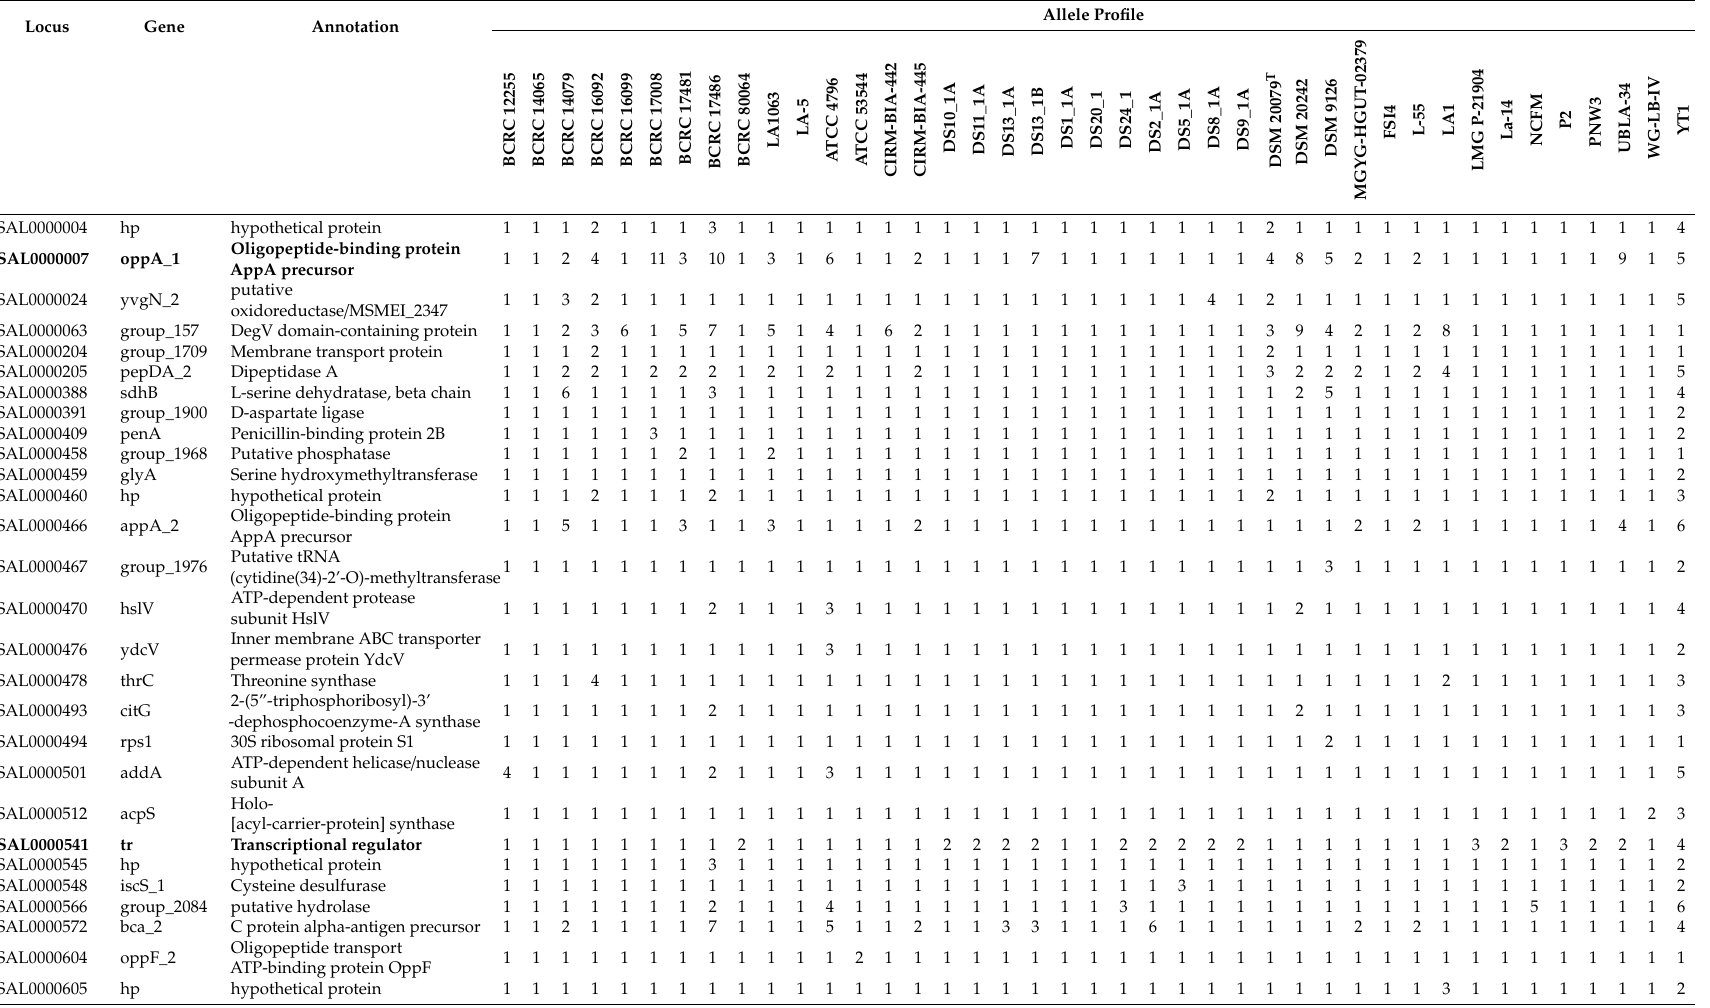
Table 3. List of the 92 highly discriminatory loci in 41 Lactobacillus acidophilus